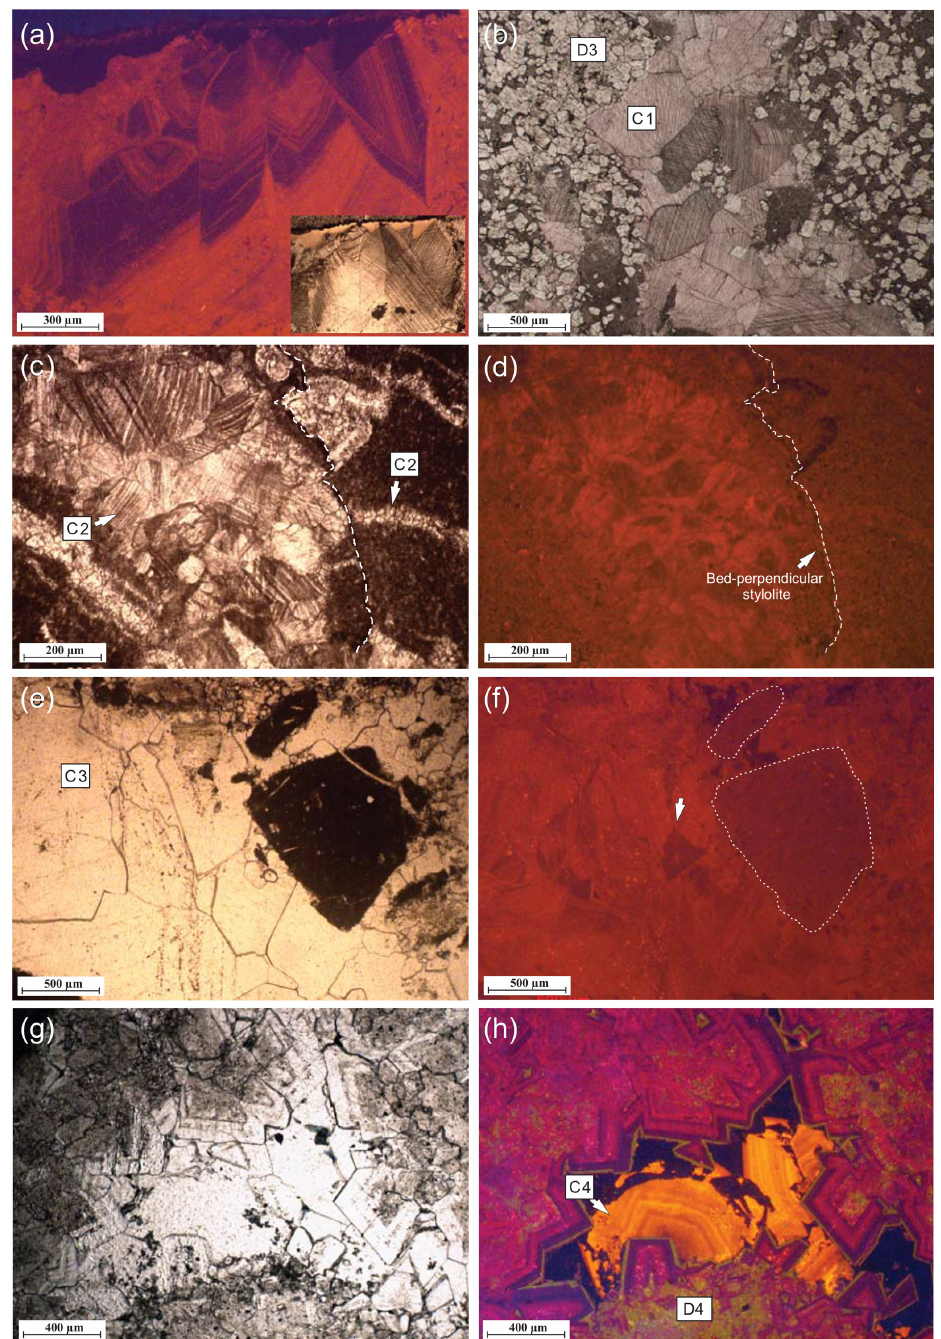
Figure 11. (a) Cathodoluminescence and transmitted light (inset) images showing blocky-to-elongated crystals of C1 with zoned CL pattern in the Corano Quarry site. (b) Transmitted light image showing intensely twinned C1 crystals overprinted by euhedral to subhedral crystals of D3 in the Corano Quarry site. Photomicrographs of transmitted light and corresponding cathodoluminescence image: (c, d) C2 in the Scaglia Formation abutted by a bed-perpendicular stylolite (indicated by white arrows and dashed line) in the Corano Quarry site. The crystals display blocky to fibrous morphologies, deformation twinning, and a similar orange luminescence pattern similar to the adjacent host rock. (e, f) C3 cementing the breccia fragments in the damage zone of the Montagna dei Fiori Fault. The crystals are blocky and show faint deformation twinning. They are brown-orange with distinct darker luminescence sector zones. (g, h) C4 presents as a cement within a polygonal pore space rimmed by dolomite, sampled from dolomitized Calcare Massiccio Formation in field site f. Note the blocky crystals, absence of deformation twinning, and distinct concentric luminescence zonation pattern. C4 is corroded and followed by a late telogenetic